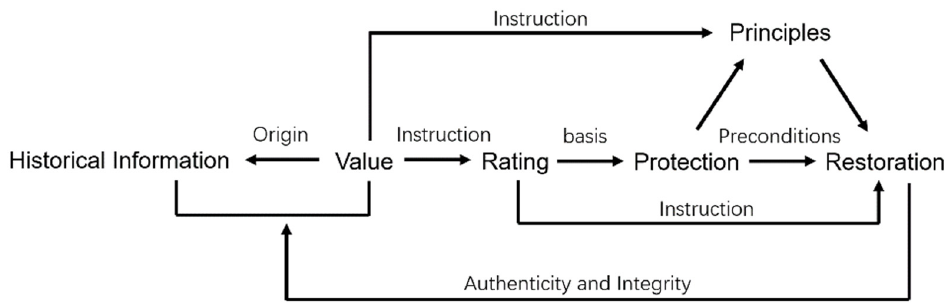
Figure 2. The value of heritage buildings and the level of protection.